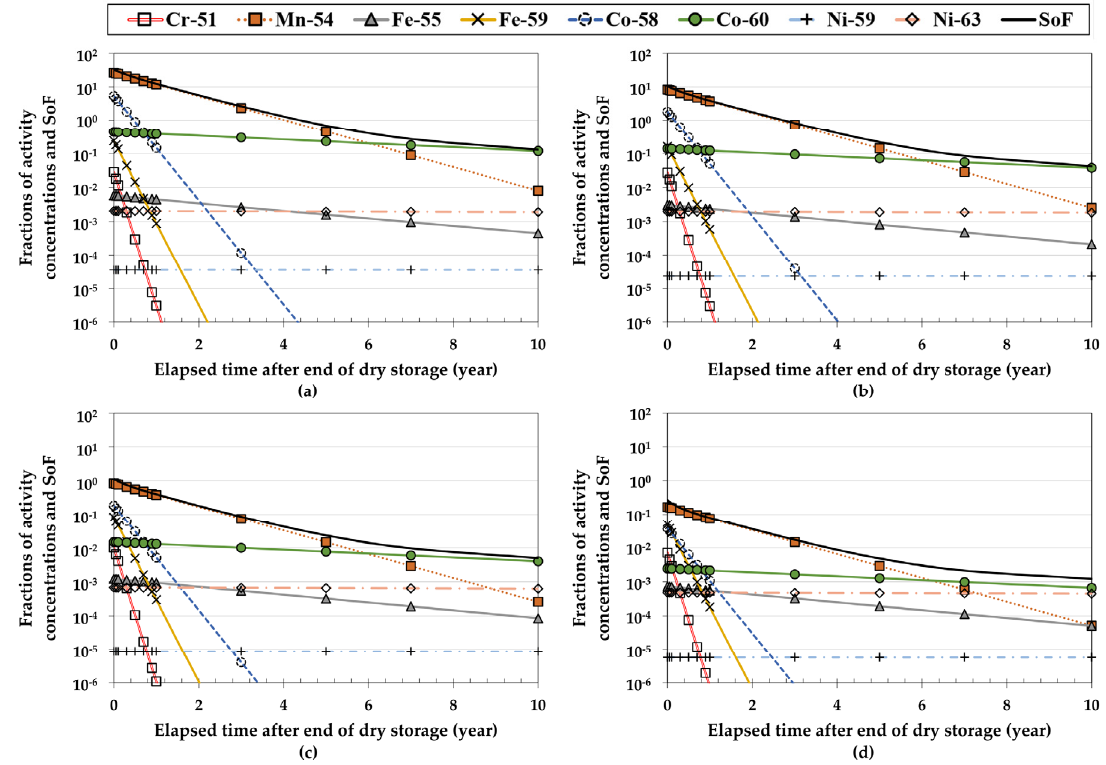
Figure 6. Fraction of estimated radioactivity concentration to the clearance level of each radionuclide together with the sum of fractions for each MPC-24 component: ( a ) basket, ( b ) shell, ( c ) baseplate, and ( d ) lid.